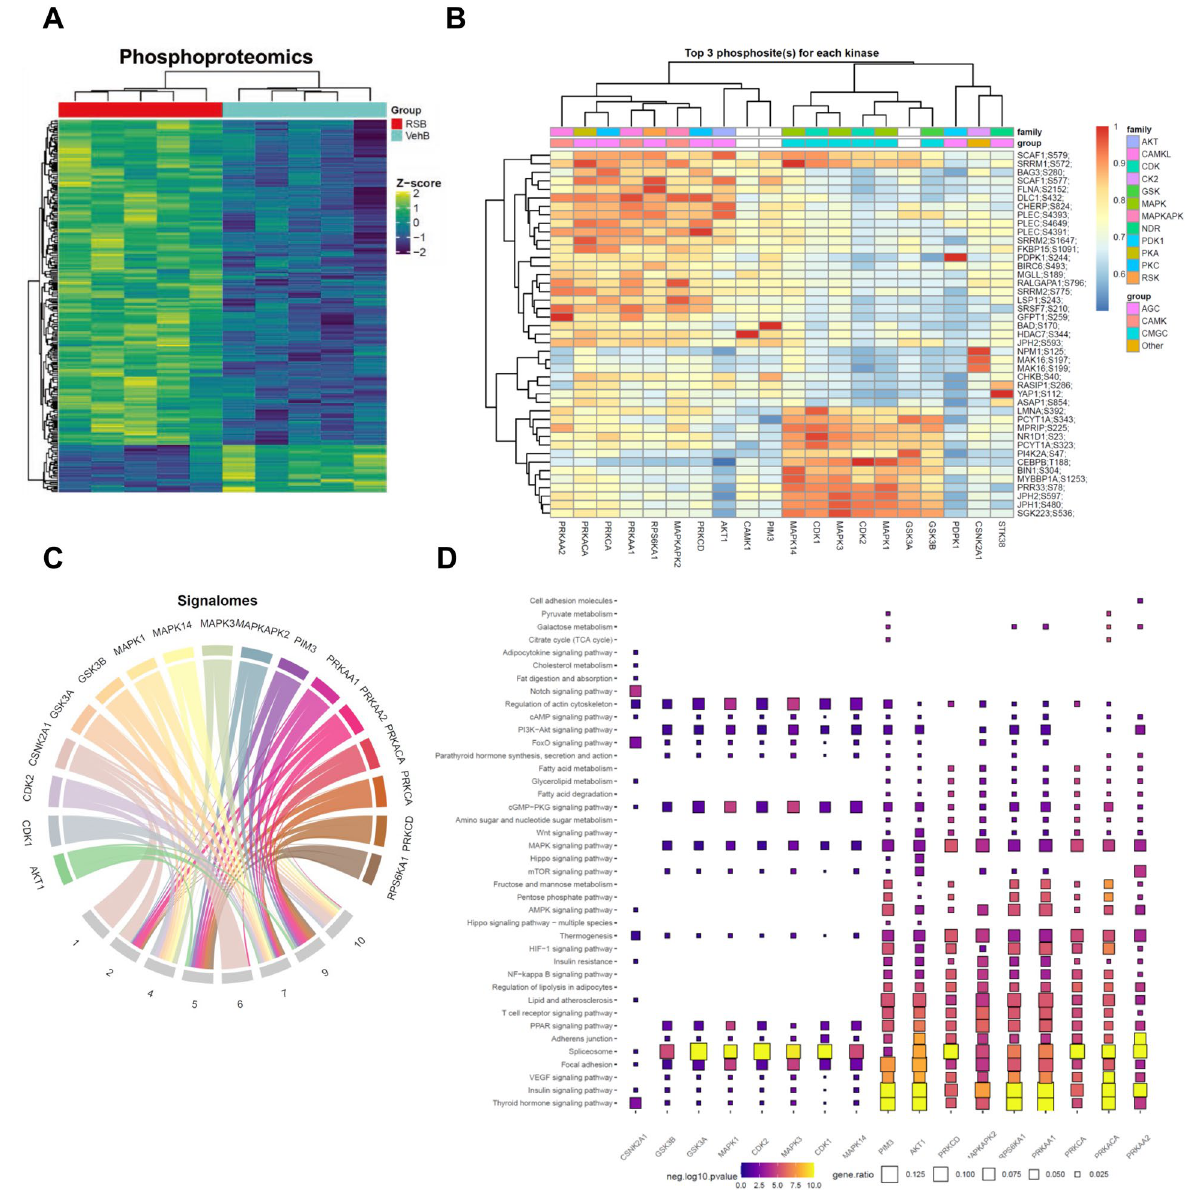
Figure 6. Roscovitine treatment leads to remodeling of BAT. ( A ) Heatmap of differential phosphoproteome in BAT of 19–20 weeks LFD and HFD fed male mice treated for 6 weeks with roscovitine or vehicle (n = 5 / group). ( B ) A clustered heatmap of the combined kinase-substrate score for the top three phosphosites of all evaluated kinases. A higher combined score denotes a better fit to a kinase motif and kinase-substrate phosphorylation profile of a phosphosite. ( C ) Signalomes identified from BAT phosphoproteome. The branching nodes consist of 17 significantly active kinases. Edges between nodes connect kinases to the protein modules they regulate. ( D ) KEGG pathway over-representation pathway analysis of kinase substrates (prediction score > 0.5). The squares are colored by negative log10 p-value (scaled across pathways) and sized by the ratio of genes present in the KEGG gene set (the larger the square, the greater the proportion of kinase substrates present in the gene set). Any pathway that is not significantly represented is depicted as a grey square. Pathways were considered to be significantly over-represented when p < 0.05. Data are illustrated using GraphPad Prism 6.0 software (GraphPad, https:// www. graph pad.